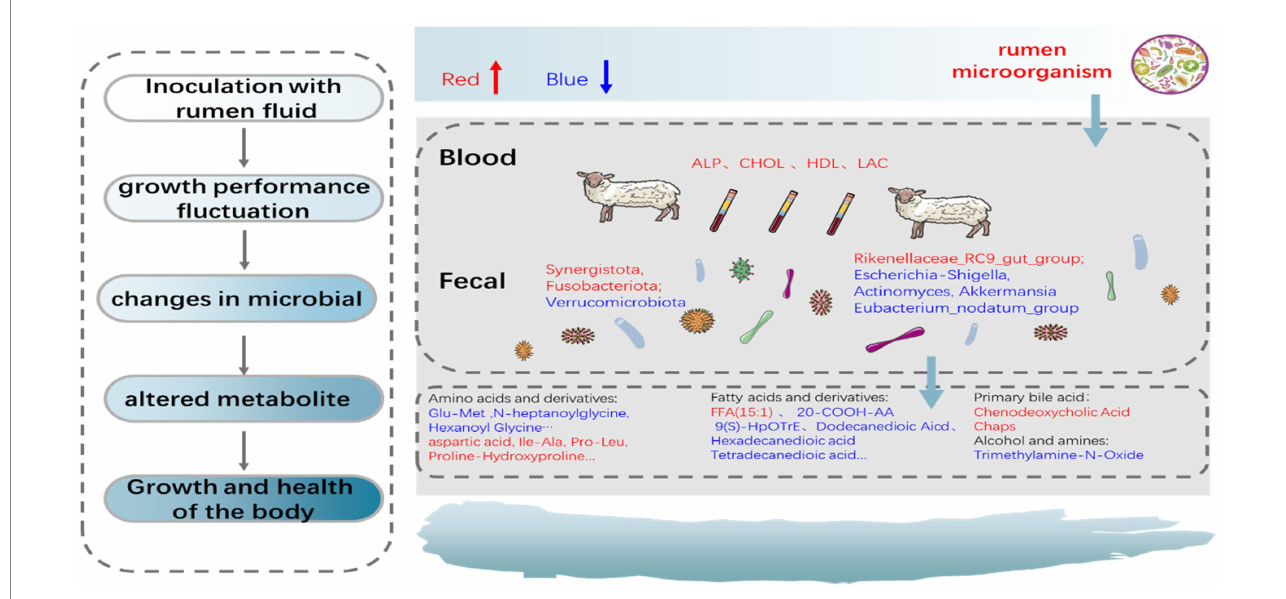
FIGURE 9 The proposed schematic diagram of the overall effects of the ruminal fluid inoculation on the gut microbial composition, function, and metabolites of